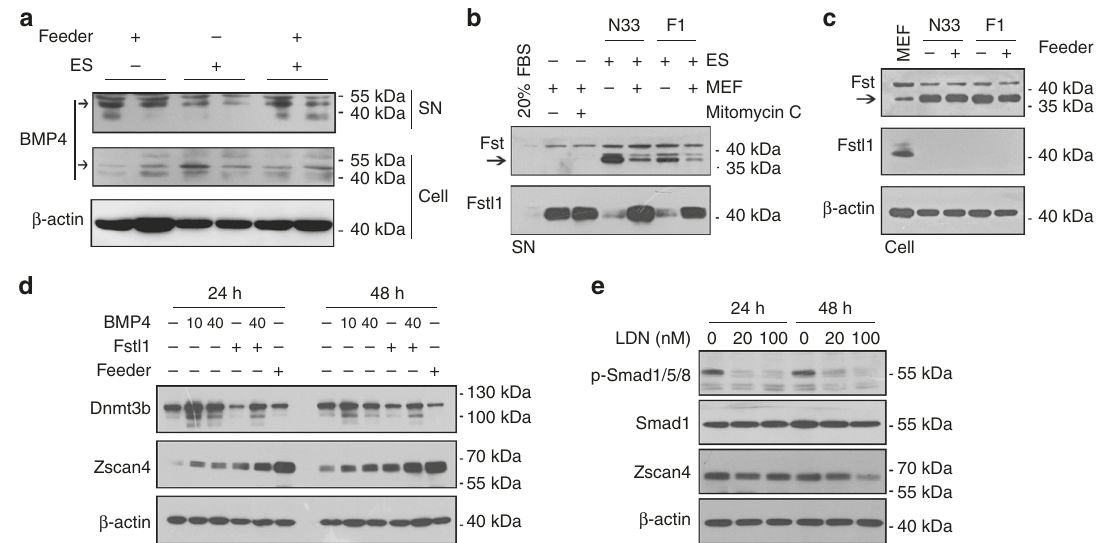
Fig. 5 BMP4 and Fstl1 secreted by feeders increase Zscan4 expression. a Western blot analysis of BMP4 in cell extracts (Cell) and in the medium (supernatant, SN) under indicated conditions. b Western blot analysis of secreted Fst and Fstl1 by MEF (with or without mitomycin C treatment), ESCs and ESCs + MEF. The band of Fst is indicated by arrow. c Western blot analysis of global protein levels of Fst and Fstl1 in MEFs and ESCs. d Western blot analysis of Zscan4 and Dnmt3b protein levels after treatment with BMP4 or/and Fstl1. BMP4, 10 ng/ml and 40 ng/ml as indicated; Fstl1, 100 ng/ml. e Western blot analysis of pSmad1/5/8 and Zscan4 protein level following treatment with BMP signaling inhibitor LDN-193189 for 24 and 48 h at the indicated concentrations. β -actin served as loading Differentially expressed genes (DEGs) were enriched in pathways including LIF-Stat3, PI3K-Akt, MAPK, TGF-beta, telomere length in ESCs cultured on the feeders. Notch and Wnt signaling (Fig. 4f). A number of genes associated with focal adhesion, ECM – receptor interaction and cytokine – cytokine receptor interaction were upregulated in ESCs with feeders, suggesting more active intercellular interactions. Some cytokines (e.g., ILs and IFNs) and receptors (e.g., ILRs) involved in LIF pathway were up-regulated in feeder + ESCs compared with feeder-free ESCs, while most of LIF targeting genes were unchanged (Supplementary Fig. 4a). Cytokines, ECMs, some growth factors and their corresponding receptors upstream PI3K-Akt were activated in ESCs with feeders (Supplementary Fig. 4b). In Wnt pathway, both activating factors (e.g., Wnts) and inactivating ones (e.g., PEDF and Dkk) were upregulated in feeder + ESCs compared with feeder-free ESCs (Supplementary Fig. 4c). Some ligands (Delta, initiating Notch; Serrate, inhibiting Notch) and receptors were expressed at higher levels in feeder + ESCs than in feeder-free ESCS. Notch targeting genes, Hes1 and Hes5 were upregulated in feeder + ESCs (Supplementary Fig. 4d). In Mek-Erk pathway, growth factors (e.g., EGFs and FGFs) and Ras were upregulated, but several Dual Speci fi city Phosphatases (DUSP1, DUSP9, DUSP10) or MKPs that dephosphorylate and inactivate ERKs 33 , also were upregu- lated in ESCs with feeders (Supplementary Fig. 4e). p-Erk1/2 level elevated in ESCs cultured with feeders relative to those without feeders, and comparatively was lower than that of MEFs (Supplementary Fig. 4f). Appropriate levels of p-Erk coincided with the high proliferation of ESCs cultured on the feeders.